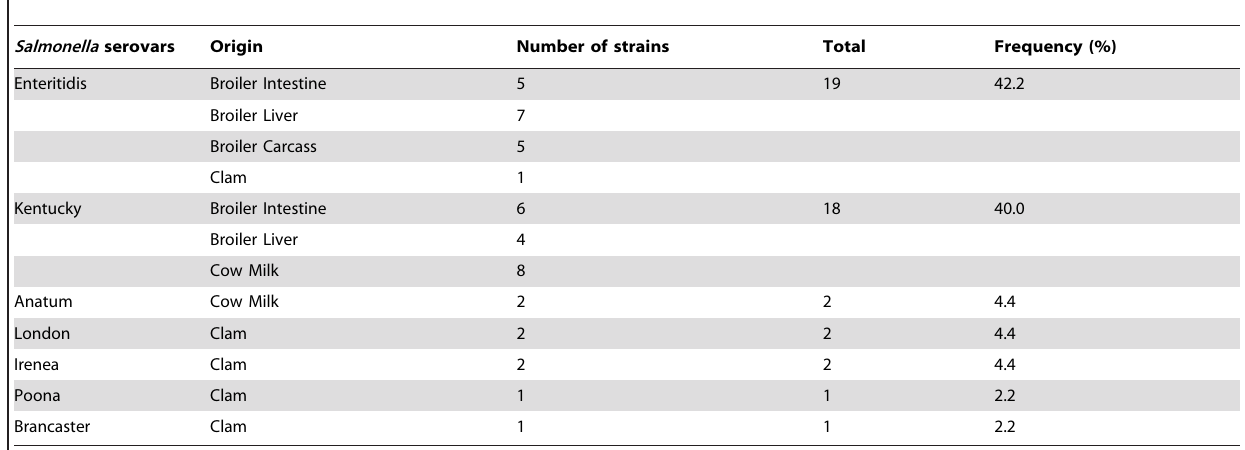
Table 1. Distribution of Salmonella isolates derived from broilers, clams and cow milk.